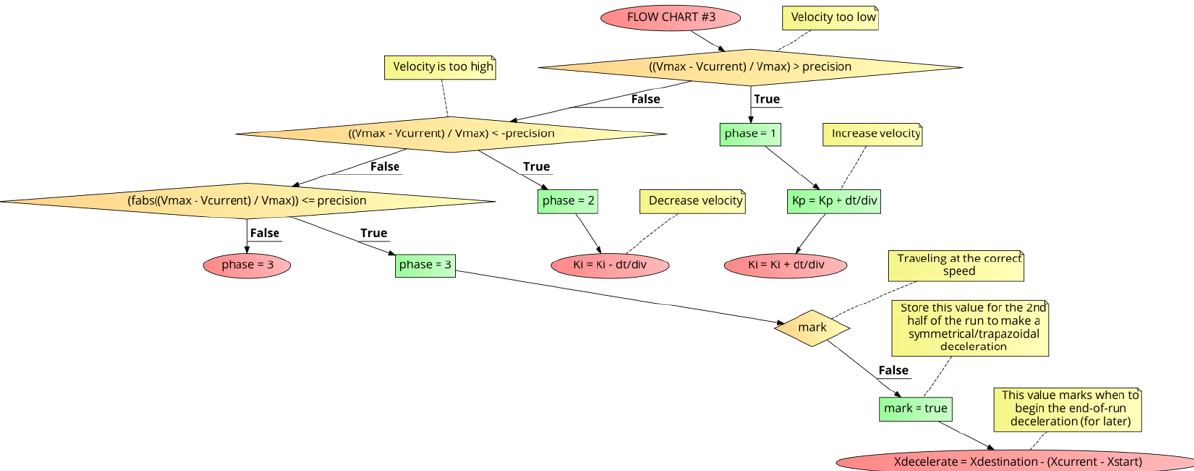
Figure 10. PID++ Flow Chart #3—first half of run (acceleration and plateau).